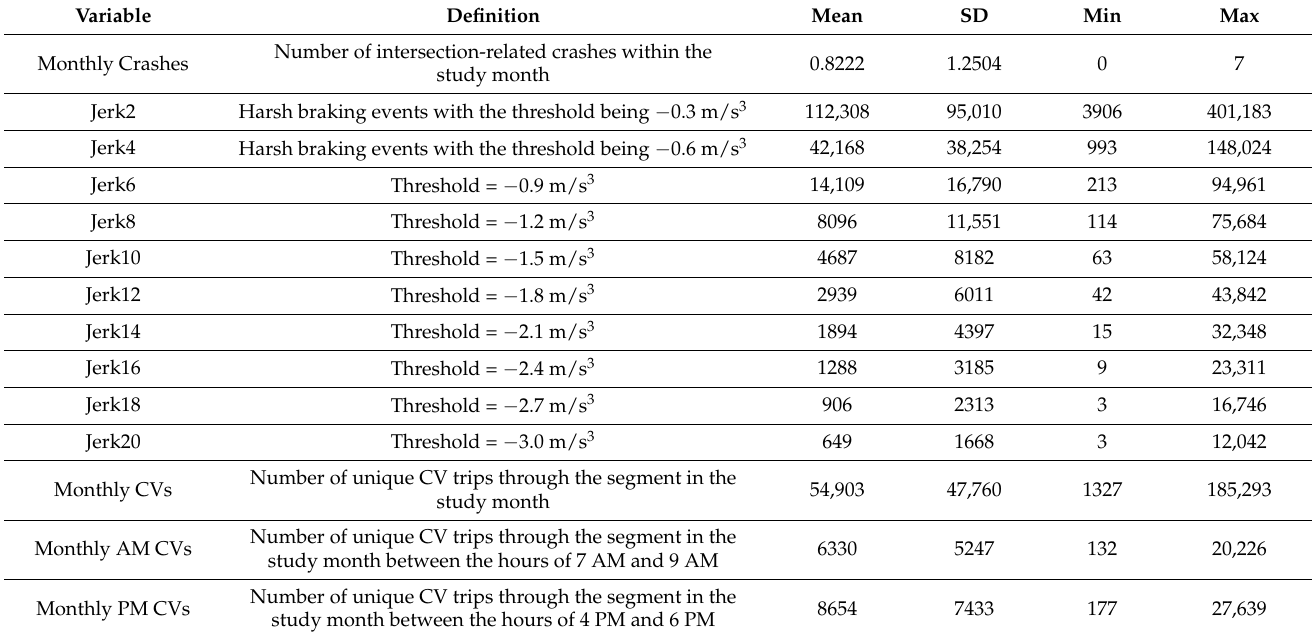
Table 2. Summary of segment variables.